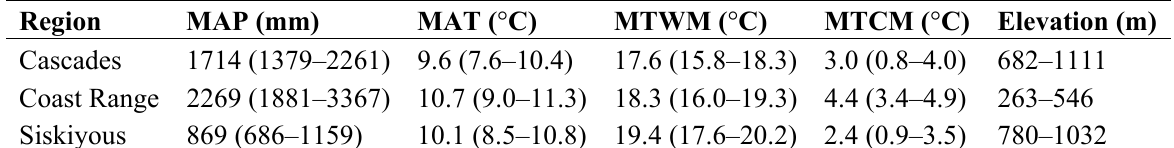
Table 1. Mean and ranges of mean annual precipitation (MAP), mean annual temperature (MAT), mean temperature of warmest month (MTWM), mean temperature of coldest month (MTCM), and elevation ranges for sampled sites, by region. Climatic data are means for 1961–1990